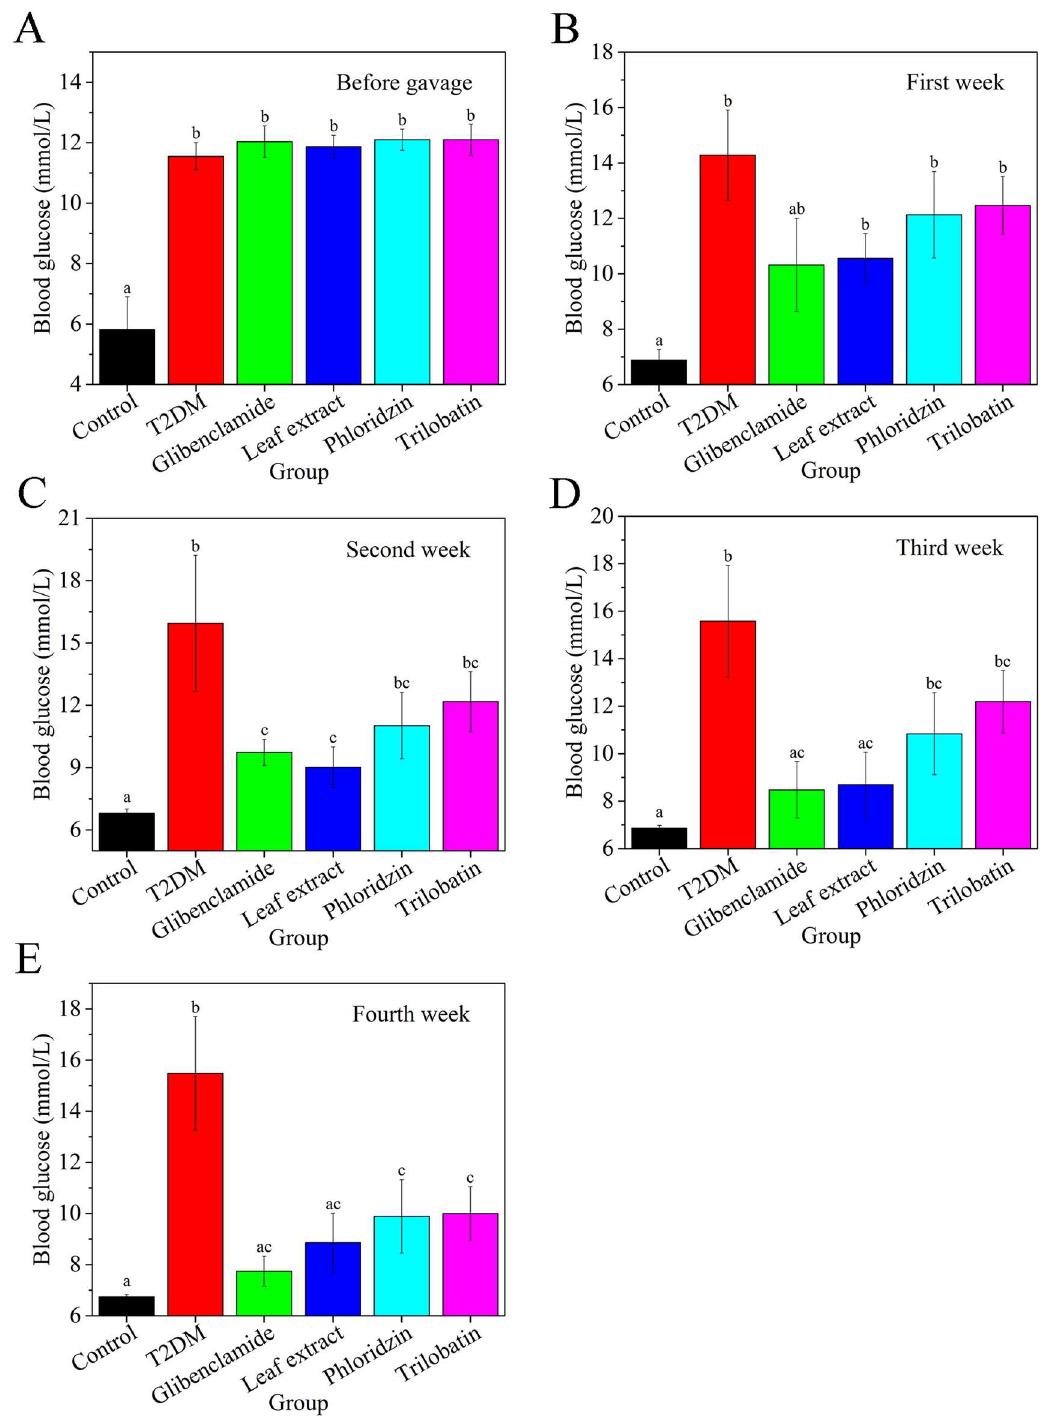
Fig 2. Leaf extractsfrom L . polystachyus Rehd. decreaseblood glucose from tail of experimental T2DM mice after gavage at different weeks. (A) was Before gavage,(B) was the First week after treatment, (C) was the Second after treatment, (D) was the Third week after treatment and (E) was the Fourth week after treatment. The data were analyzedwith ANOVA. All the values are expressedas the mean ± SEM, n = 10. Columnslabeledwith different letters are significantly different at P <